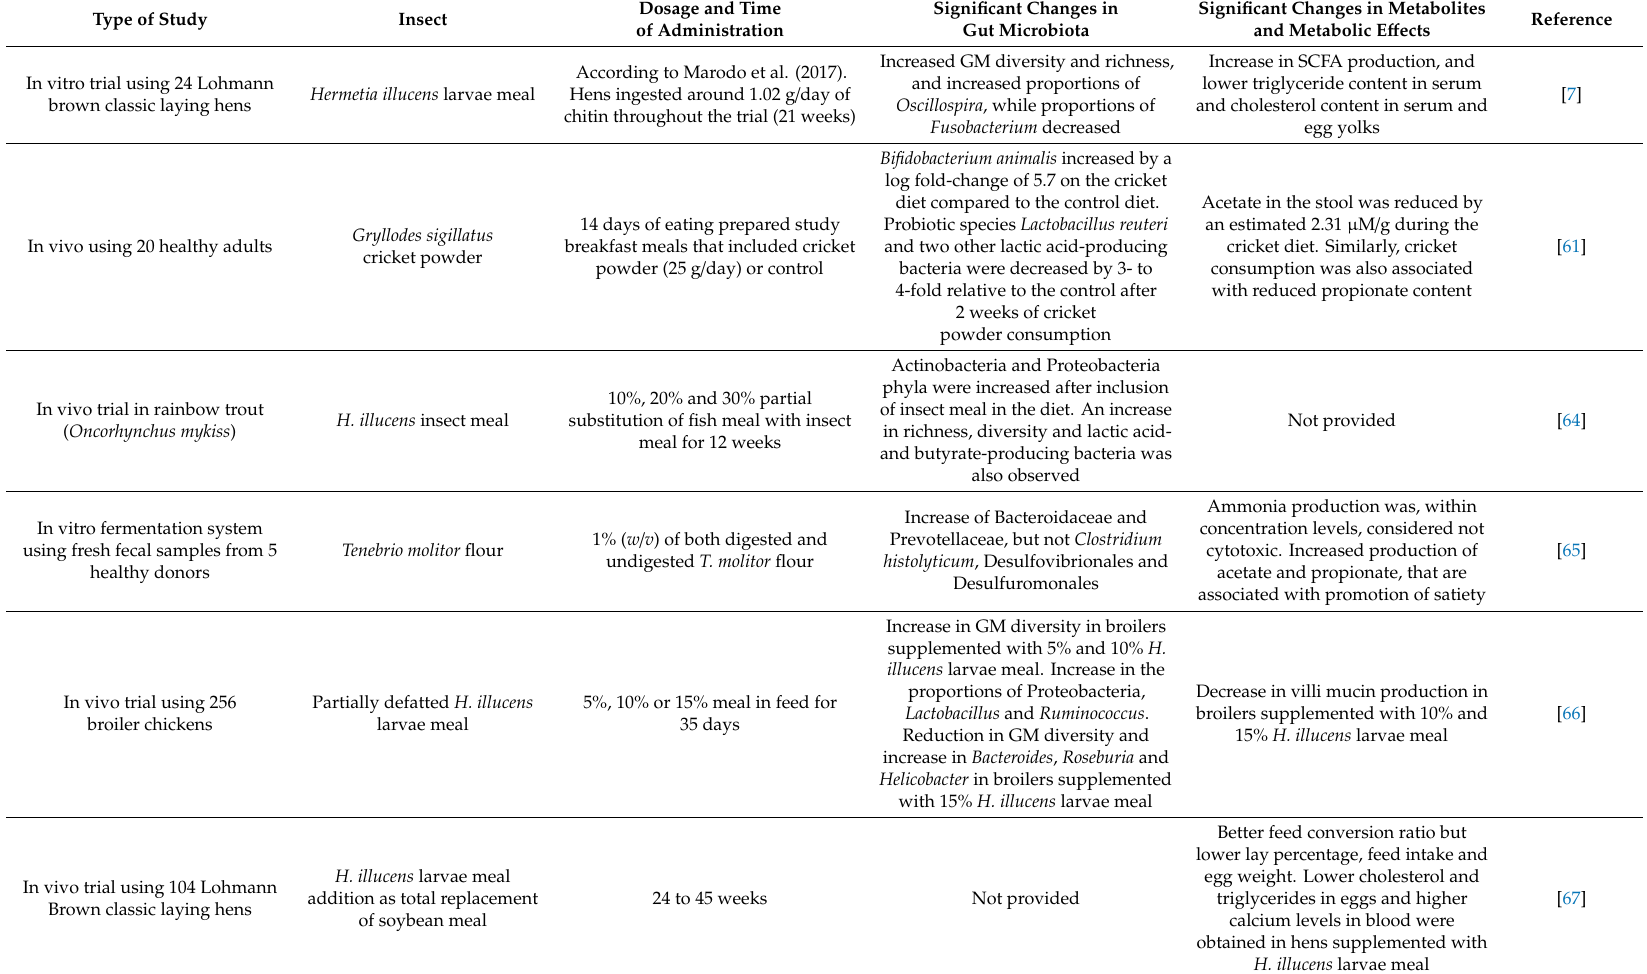
Table 1. E ff ects of administration of whole insects or insect flour on gut